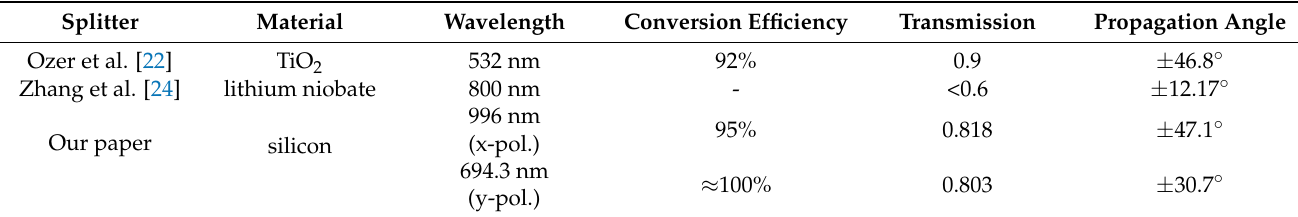
Table 1. Optical performances of our proposed beam splitter and previously reported splitters based on discrete dielectric